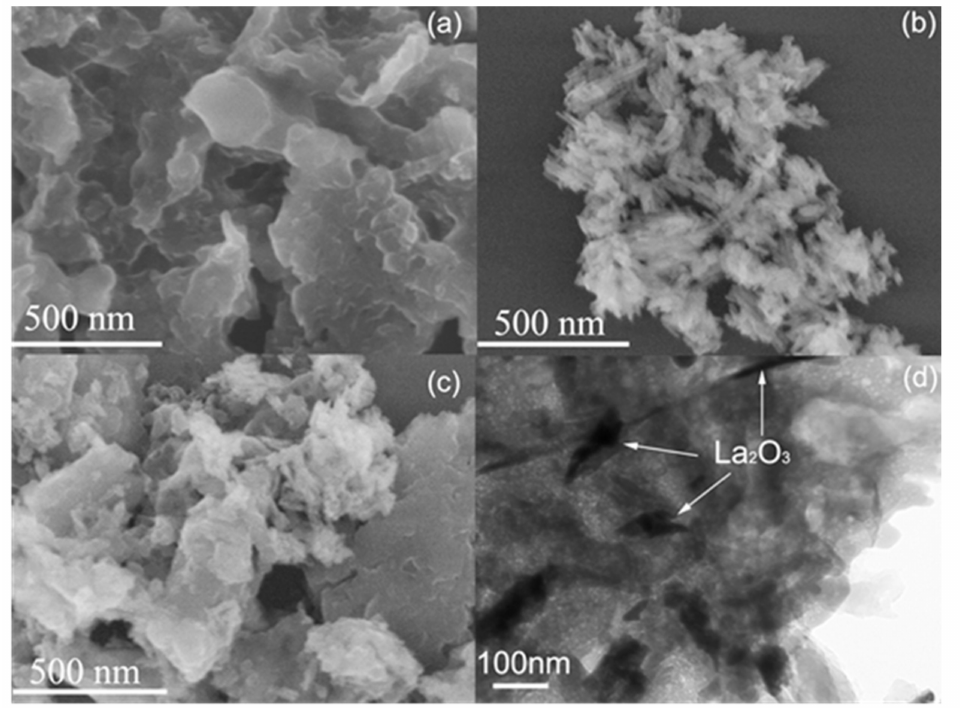
Figure 2. FESEM patterns of CN sample ( a ), LaO sample ( b ), 10LaO/CN sample ( c ), and TEM pattern of 10LaO/CN sample ( d